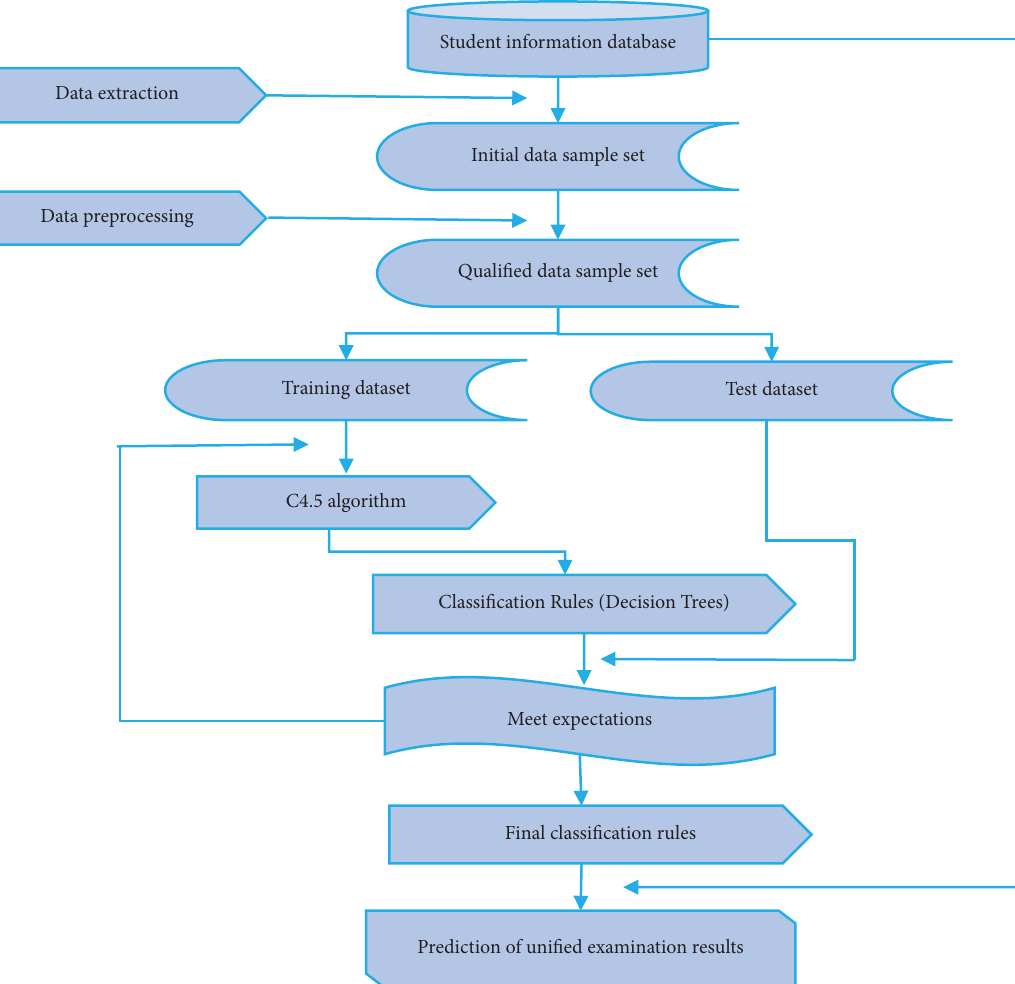
Figure 9: Te prediction model of English teaching achievement based on decision tree